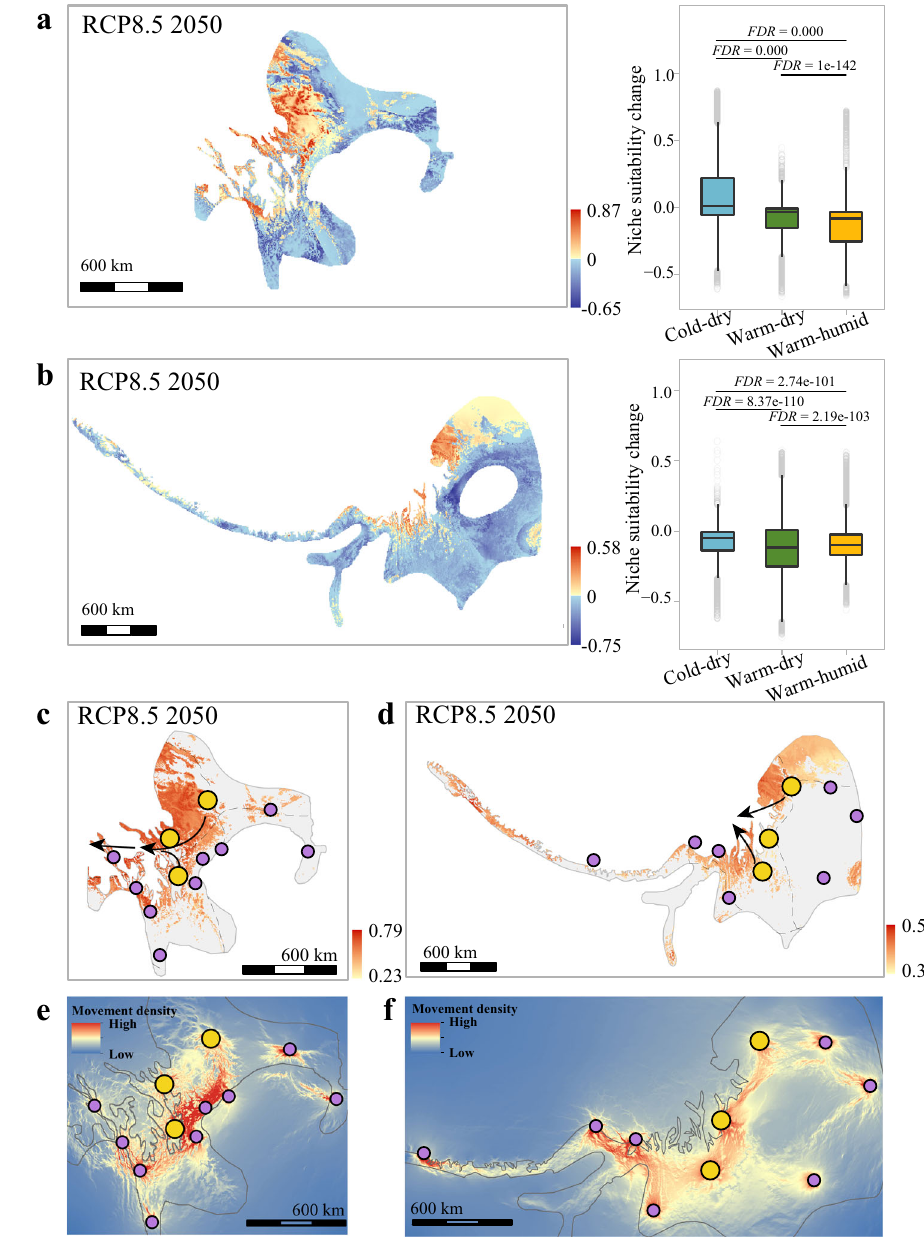
Fig. 5 | Niche suitability change predicted by ecological niche modelling and evolutionary rescue routes identi fi ed by the landscape genetic analysis. a , b Left, projection of nichesuitability changebetweencurrent and futureclimate conditions under RCP8.5 2050 (niche suitability indexpredicted for futureclimate minus niche suitability index for current climate). The reddish colours show areas with increasing niche suitability (>0), and blue colours show areas with decreasing niche suitability (<0). Right, the warm-humid ( T. elliotii , n =7061 grids; P. mon- ticolus , n =30,336grids)andwarm-drytolerantgroups( T.elliotii , n =15,416grids; P. monticolus , n =42,929 grids) are under the severer challenge for niche suitability decline than are the cold-dry tolerant groups ( T. elliotii , n =21,402 grids; P. mon- ticolus , n =6926 grids). We tested niche suitability change among these groups using the two-tailed Wilcoxon rank-sum test and FDR correction for multiple comparisons. The box plots show the median (centre line) and 25th − 75th percen- tiles (box limits). The whiskers extend to the top/bottom to the maxima